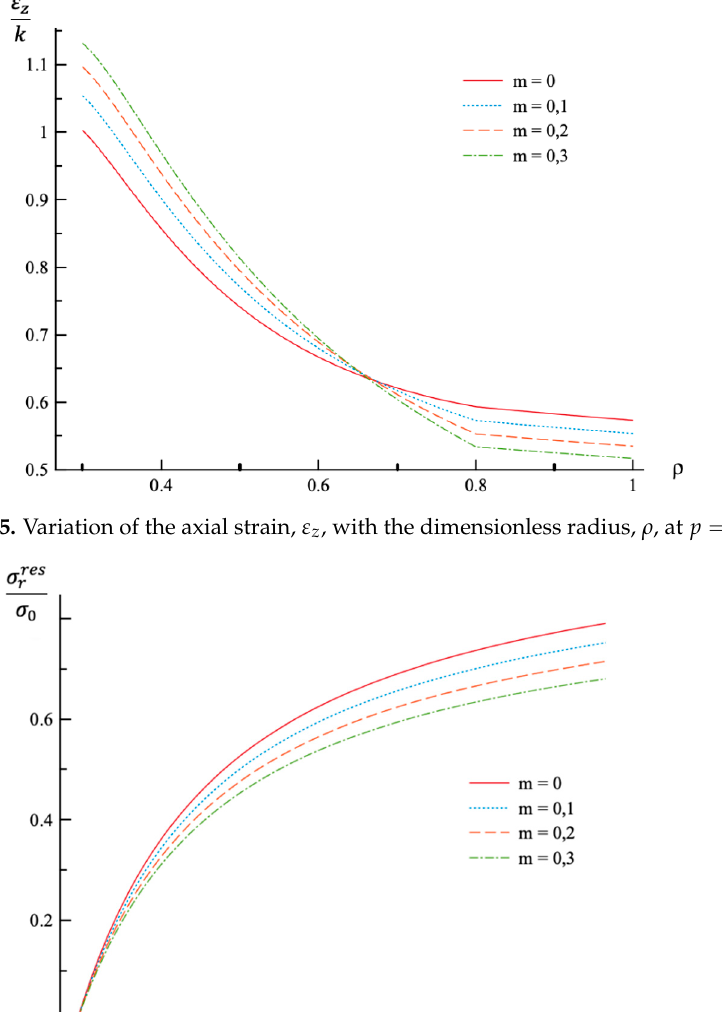
Figure 4. Variation of the circumferential strain, ε θ , with the dimensionless radius, ρ , at p = p f .